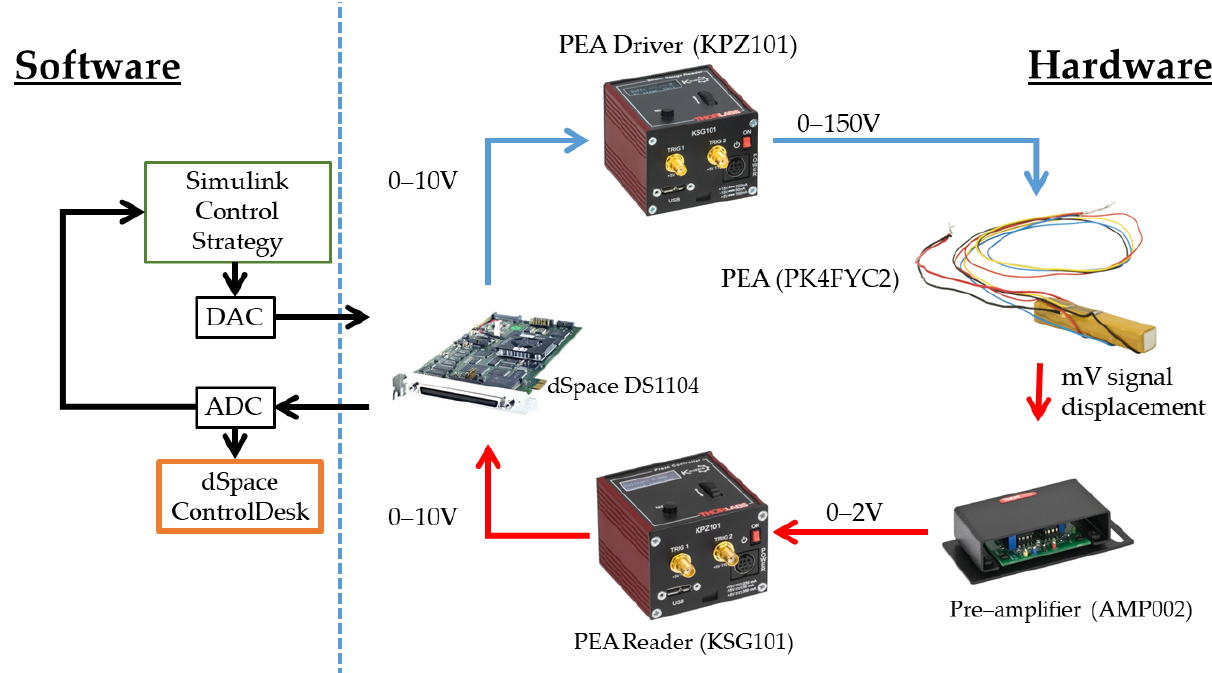
Figure 1. Hardware and software